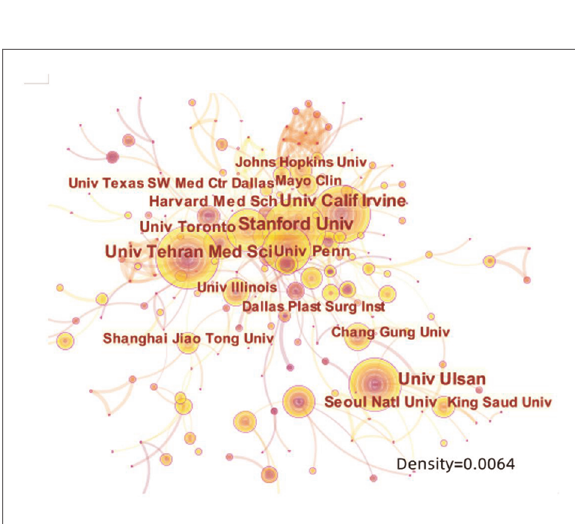
FIGURE 5 The network map of institutions that involved in rhinoplasty research